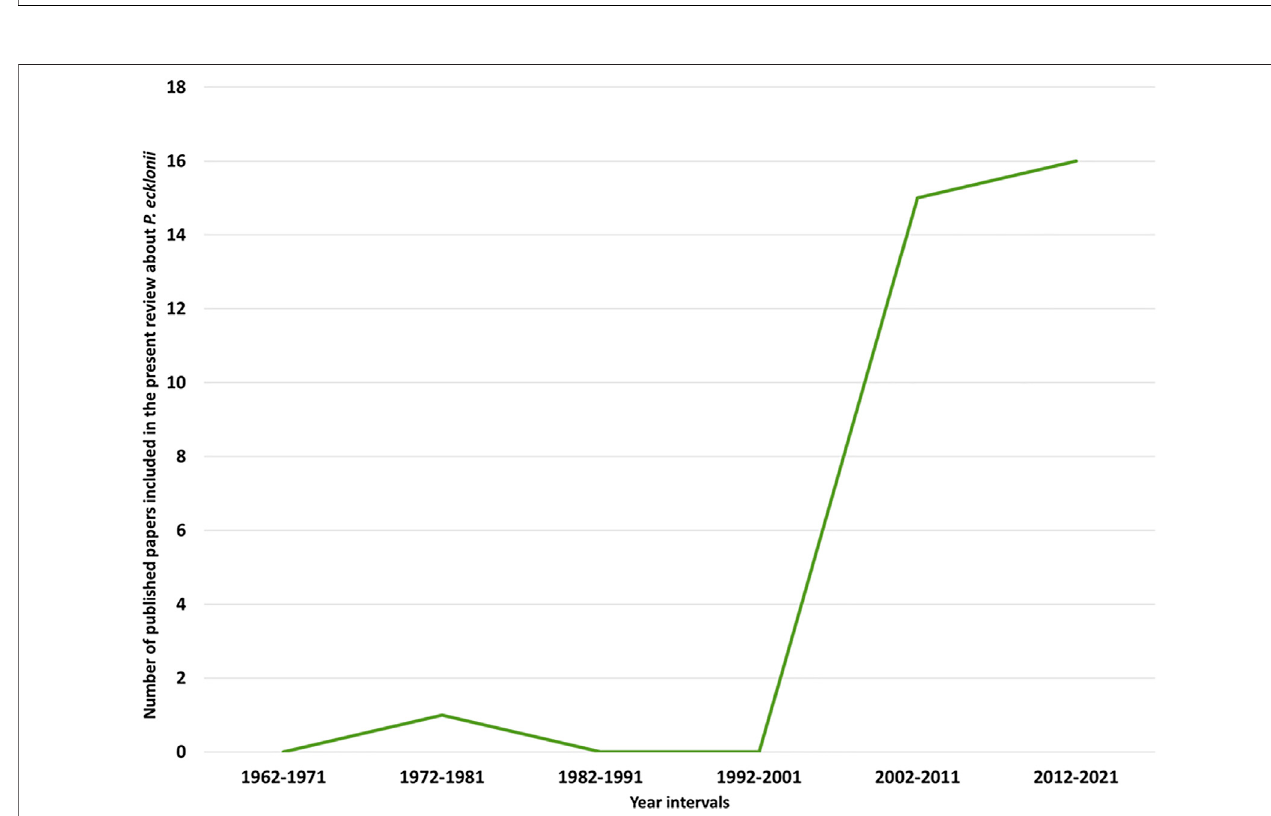
FIGURE 1 | Plectranthus ecklonii “ Medley-Wood ” (blue), P. ecklonii “ Tommy ” (white), and P. ecklonii “ Erma ” (pink) (Van Jaarsveld, 2006).